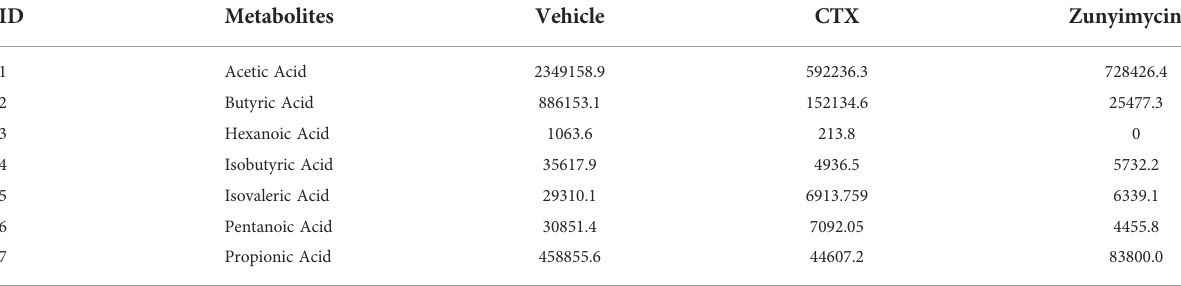
TABLE 4 SCFAs in intestinal tract of